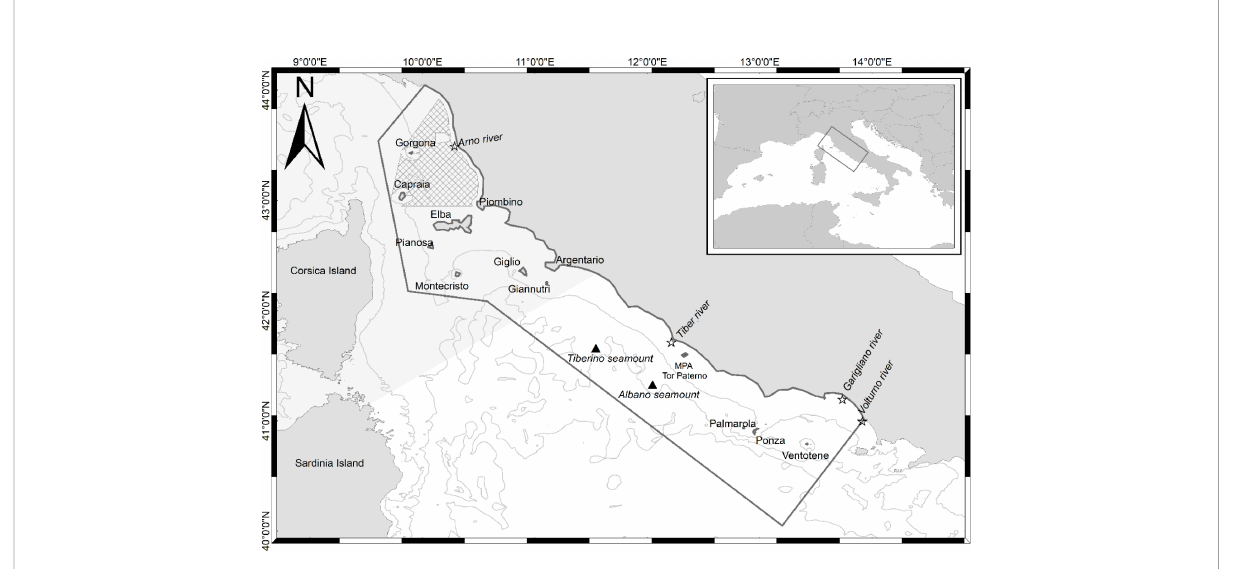
FIGURE 1 Study area in the Mediterranean Sea,